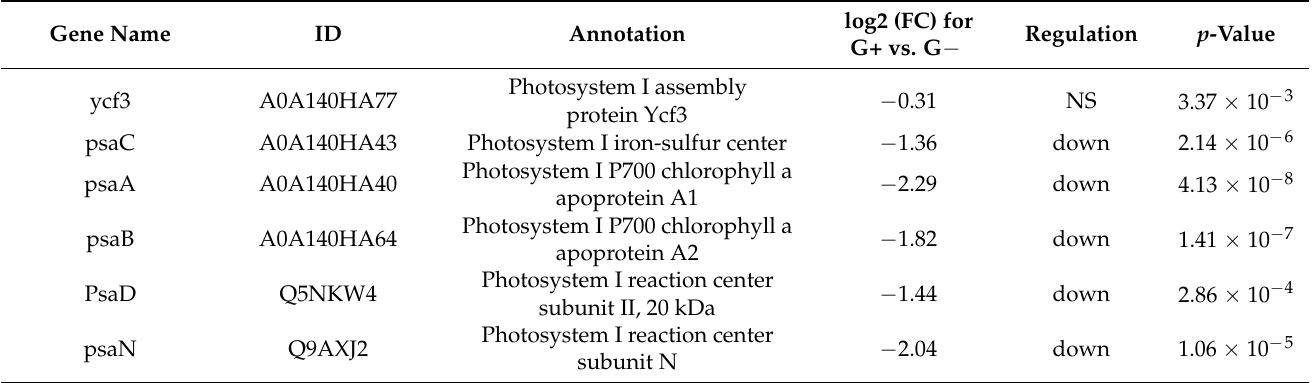
Table 3. Differentially expressed proteins involved in energy of Chromochloris zofingiensis with or without glucose